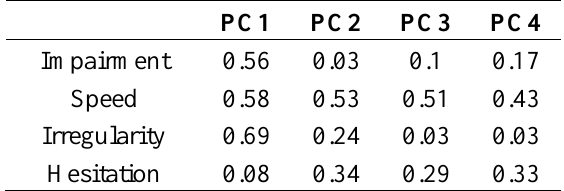
Table 3. Absolute Spearman rank correlations between the first four principal components (PCs) and mean visual ratings of individual kinematic